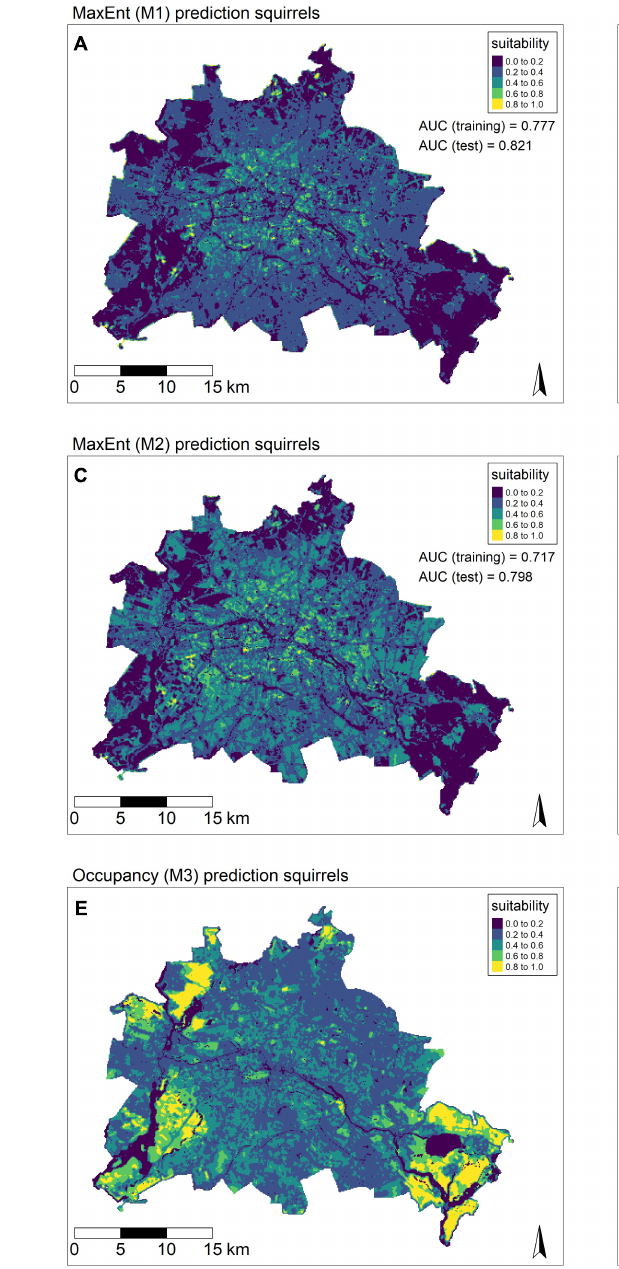
(M3) In the occupancy model, detection probability averaged over all seasons was 0.437 ( ± 0.024), increasing in the spring seasons to 0.633 ( ± 0.036). The modeling results clearly pointed to one global model after the model selection process,